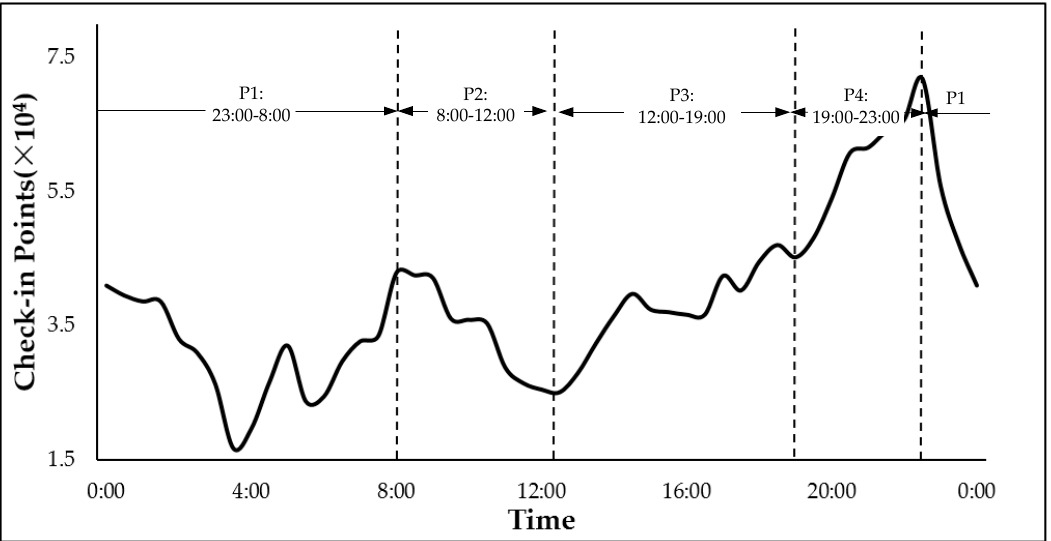
Figure 12. Time period and volume of four dataset components.